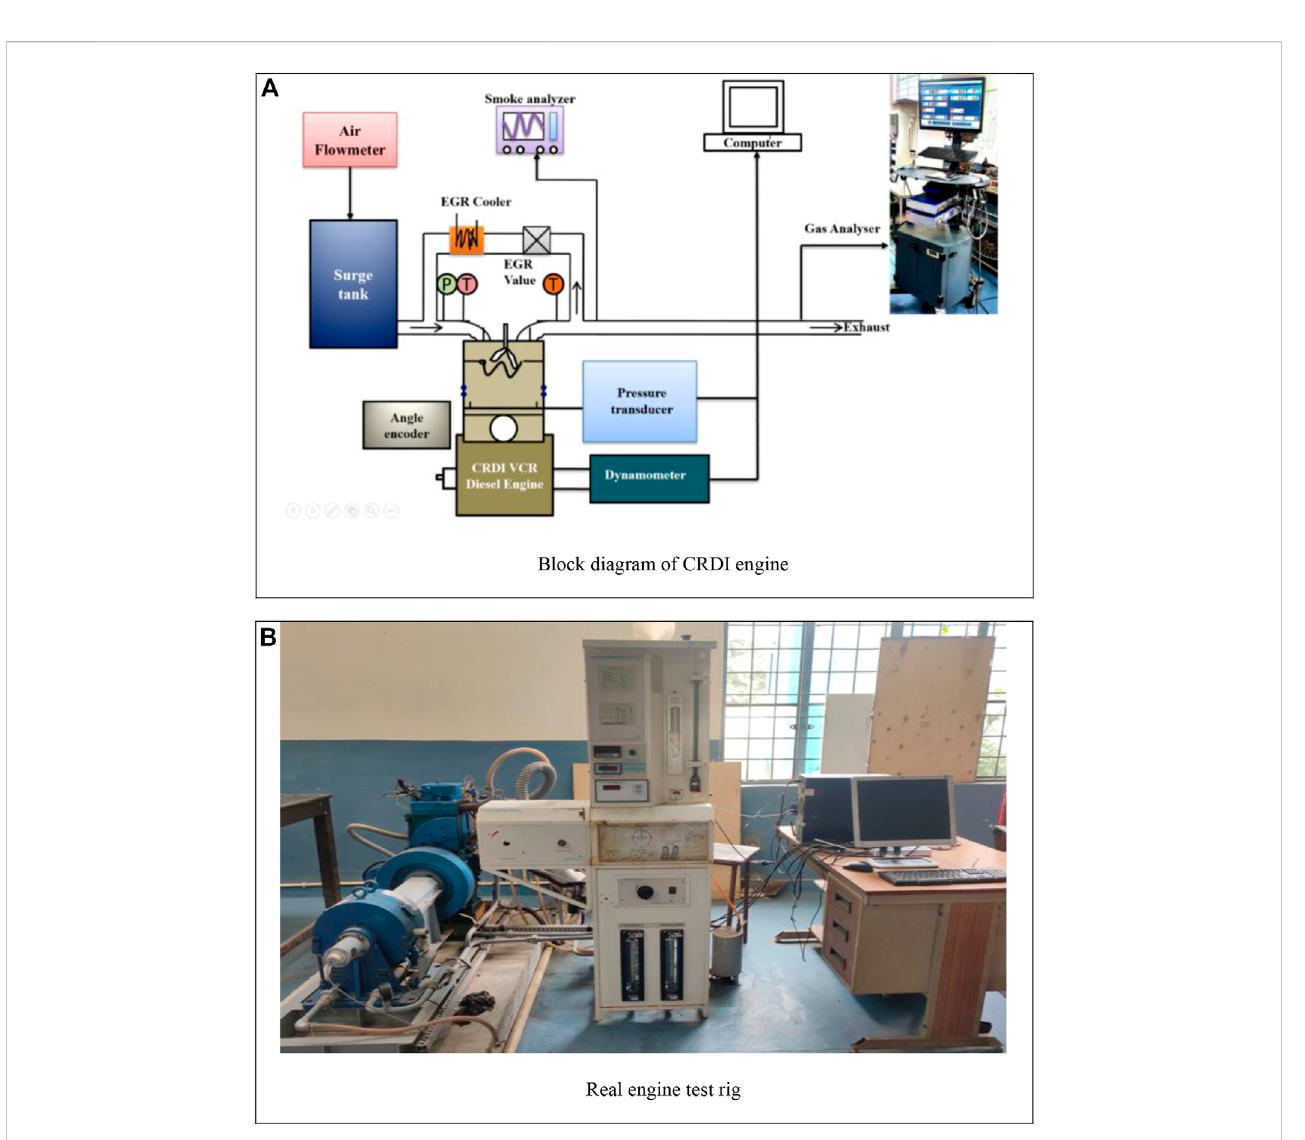
FIGURE 2 The CRDI diesel engine setup. (A) Block diagram of CRDI engine. (B) Real engine test